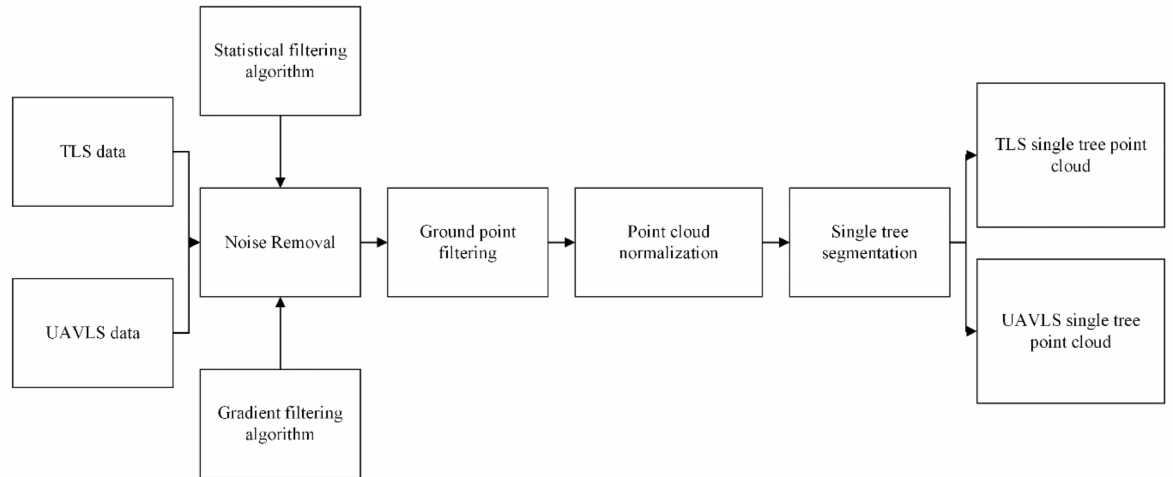
Figure 3. Point cloud data processing flow chart.